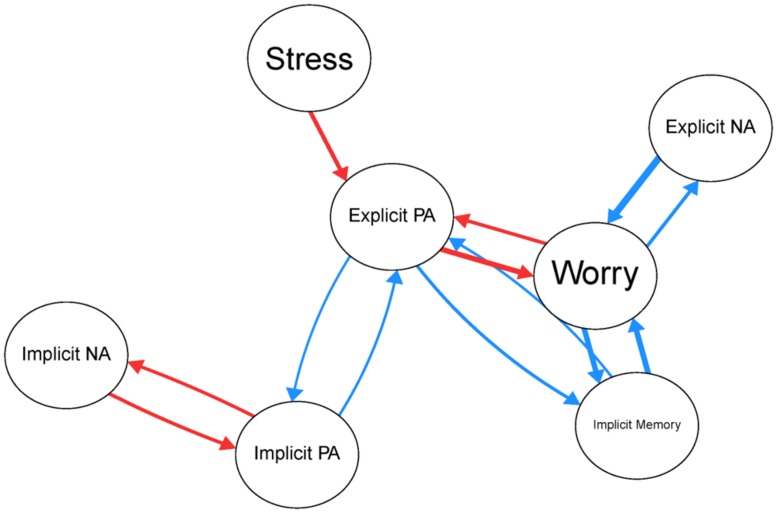
Significant associations between the psychological variables. Blue lines indicate positive associations and red lines indicate negative associations. Thicker lines represent stronger associations.